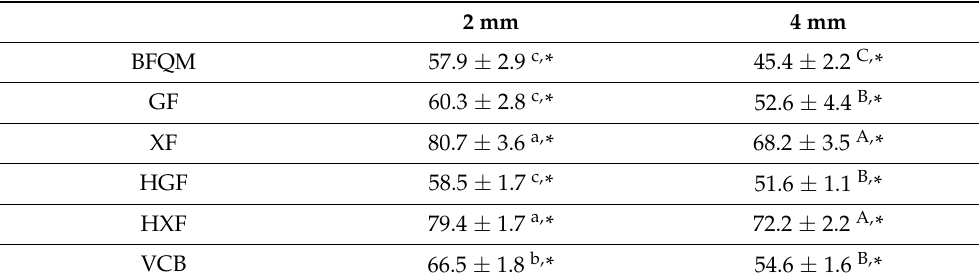
Table 4. Means ± standard deviations for the effect of CAD/CAM thickness and resin composite type on HV (Kgf/mm 2 ) of the different resin